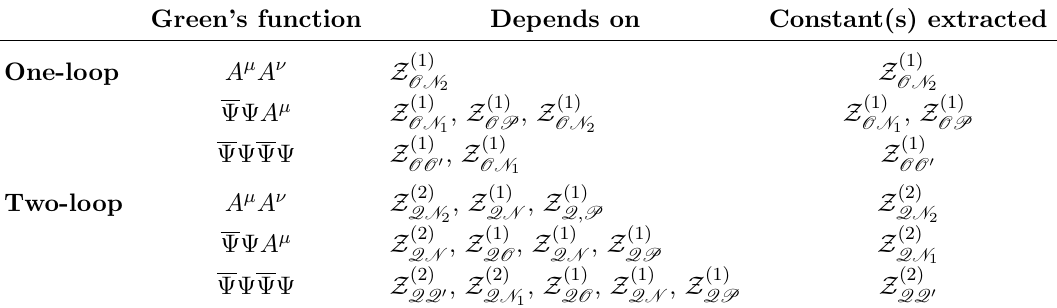
Table 1 . A summary of the Green’s functions we consider. The loop order ( L -loop) refers to the (cid:11) L contribution to the corresponding Green’s function (second column). The third column contains the mixing renormalization constants that the given Green’s function depends on. The last column contains the ones we extract in each